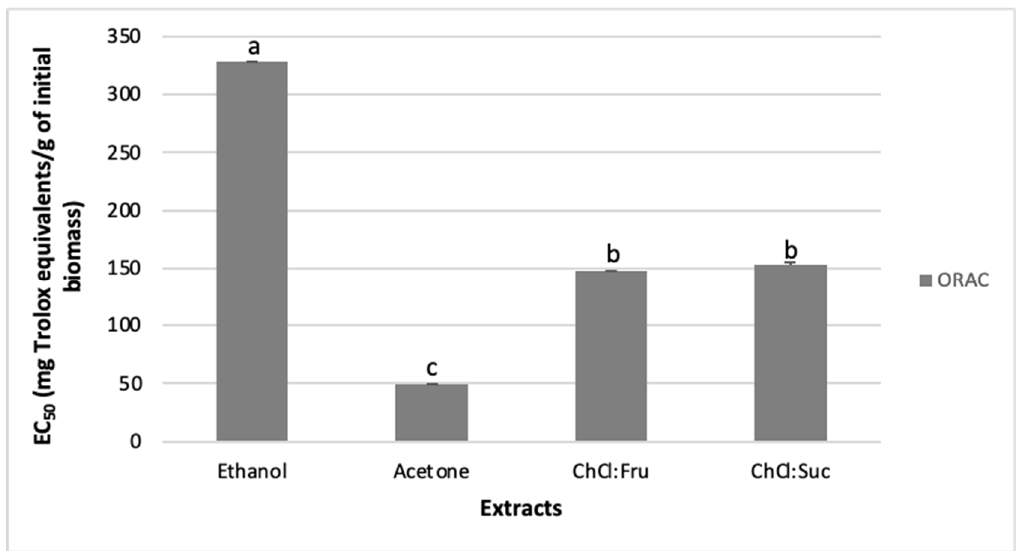
Figure 1. Radical scavenging activity (RSA) on 2,2-diphenyl-1-picrylhydrazyl (DPPH) and copper chelating activity (CCA), expressed as EC 50 values (mg of initial biomass per mL) of the extracts from Polygonum maritimum L. (sea knotgrass). Results are presented as mean values ± standard error (SE) of at least six replicates (n = 6). Columns with different letters are significantly different at p < 0.05 (Duncan’s new multiple range test). Positive control for DPPH: BHT (butylated hydroxytoluene); positive control for CCA: EDTA (ethylenediaminetetraacetic acid).